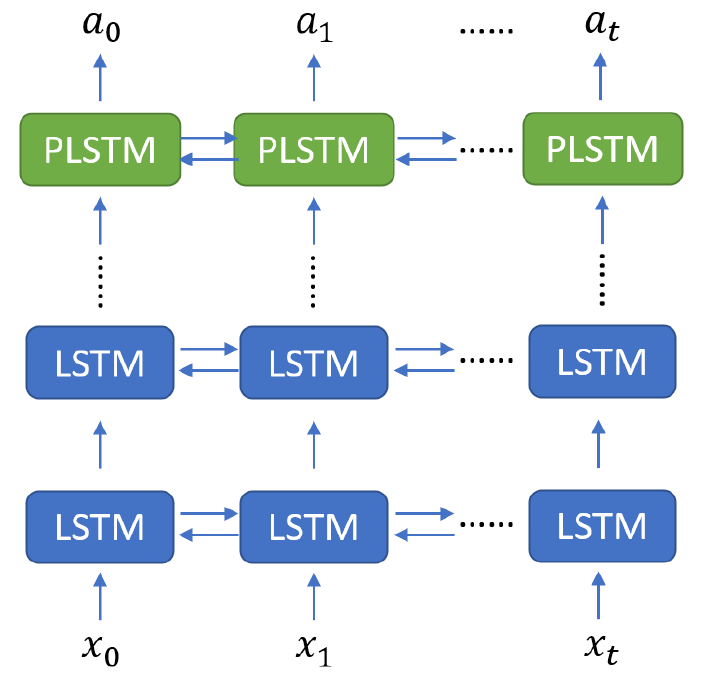
Figure 2. Period states updating module in multi-layer bi-directional LSTM network.